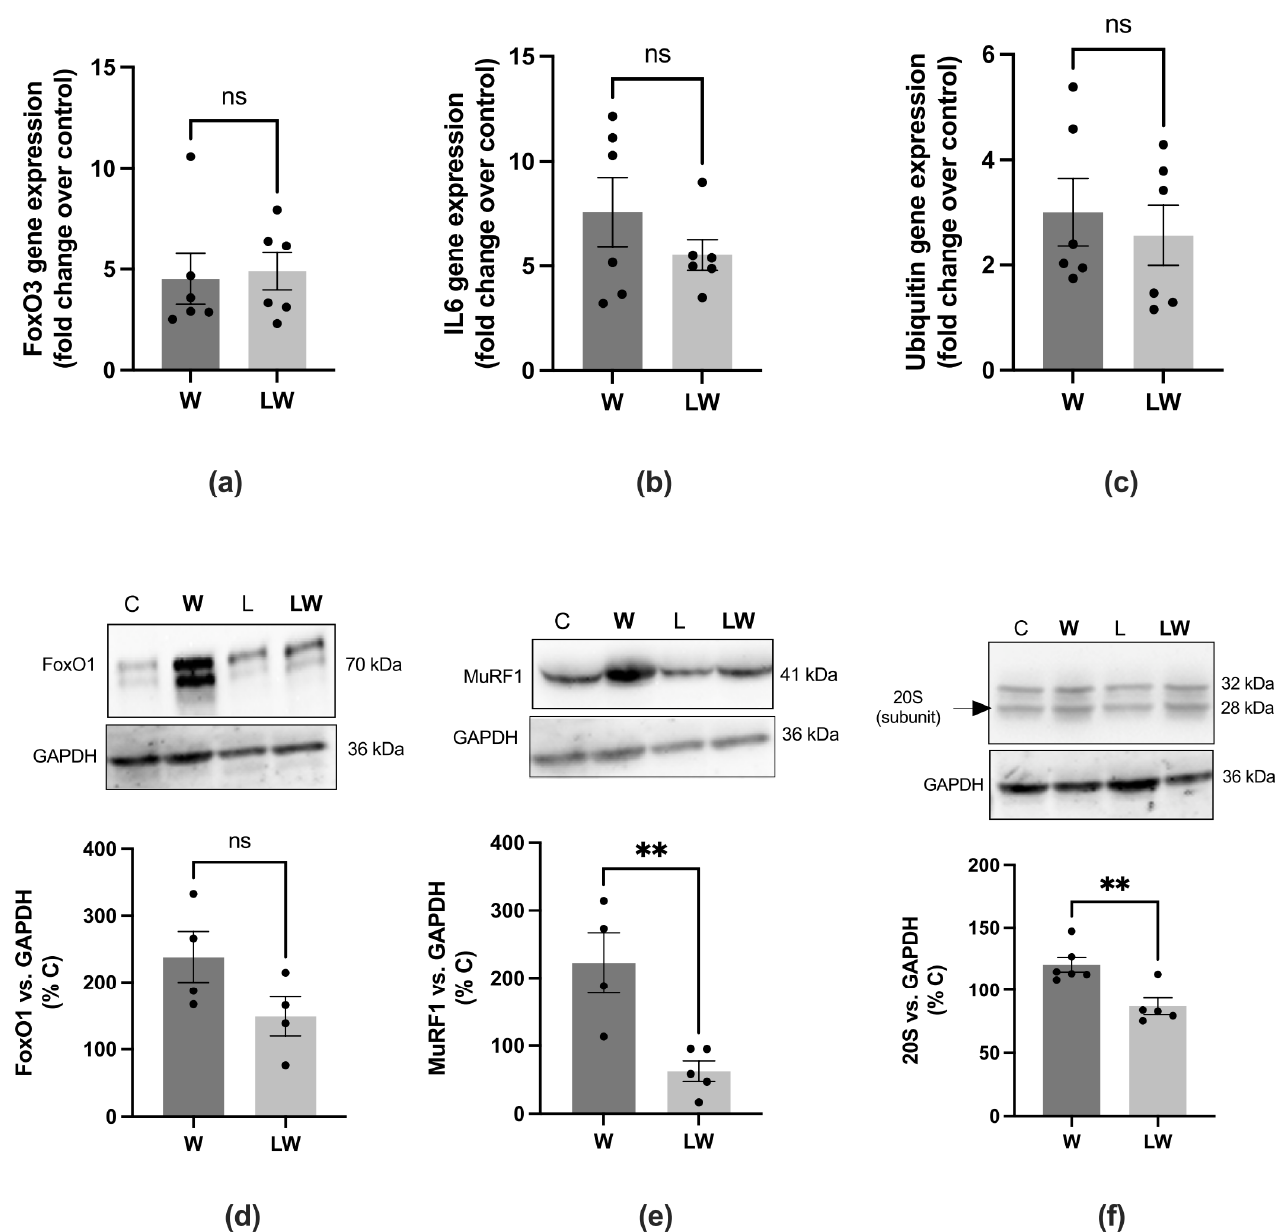
Figure 6. Muscular gene and protein expression among the different experimental groups. Gene expression of ( a ) FoxO3, ( b ) IL6 and ( c ) ubiquitin. Protein expression. Western blot analysis images from ( d ) FoxO1, ( e ) MuRF-1, and ( f ) 20S expressions in tibialis anterior muscle biopsies. Bar graphs indicating western blot analysis representing values of band volume. GAPDH was the housekeeping protein. For details, see the Methods section. Graphics represent mean ± SEM. N = 6 animals per group.** p < 0.01 and ns = not significant by t -test.